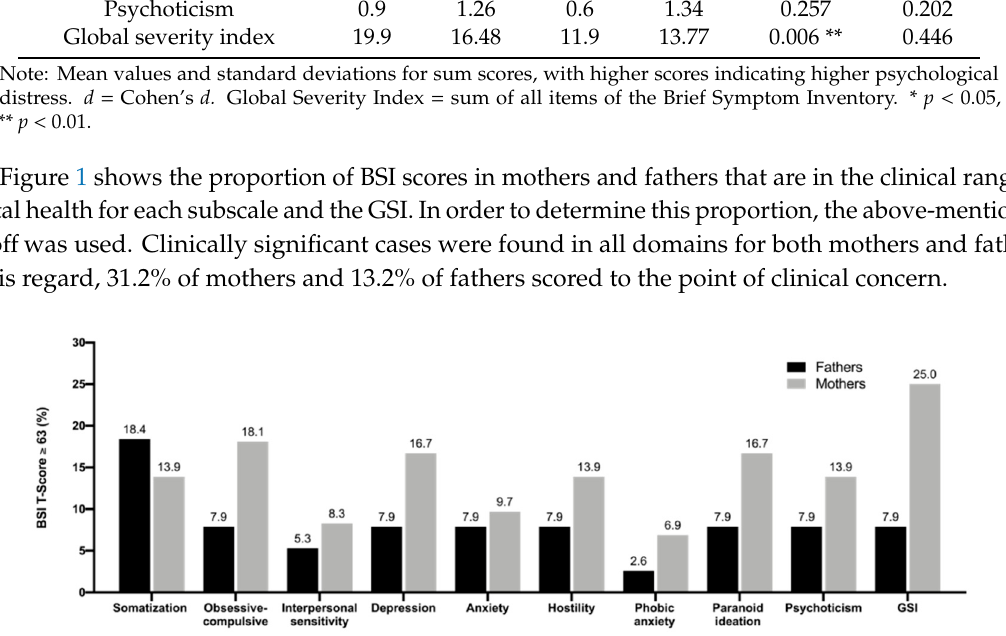
Table 3. Comparison of mental health between mothers and fathers of children and adolescents with